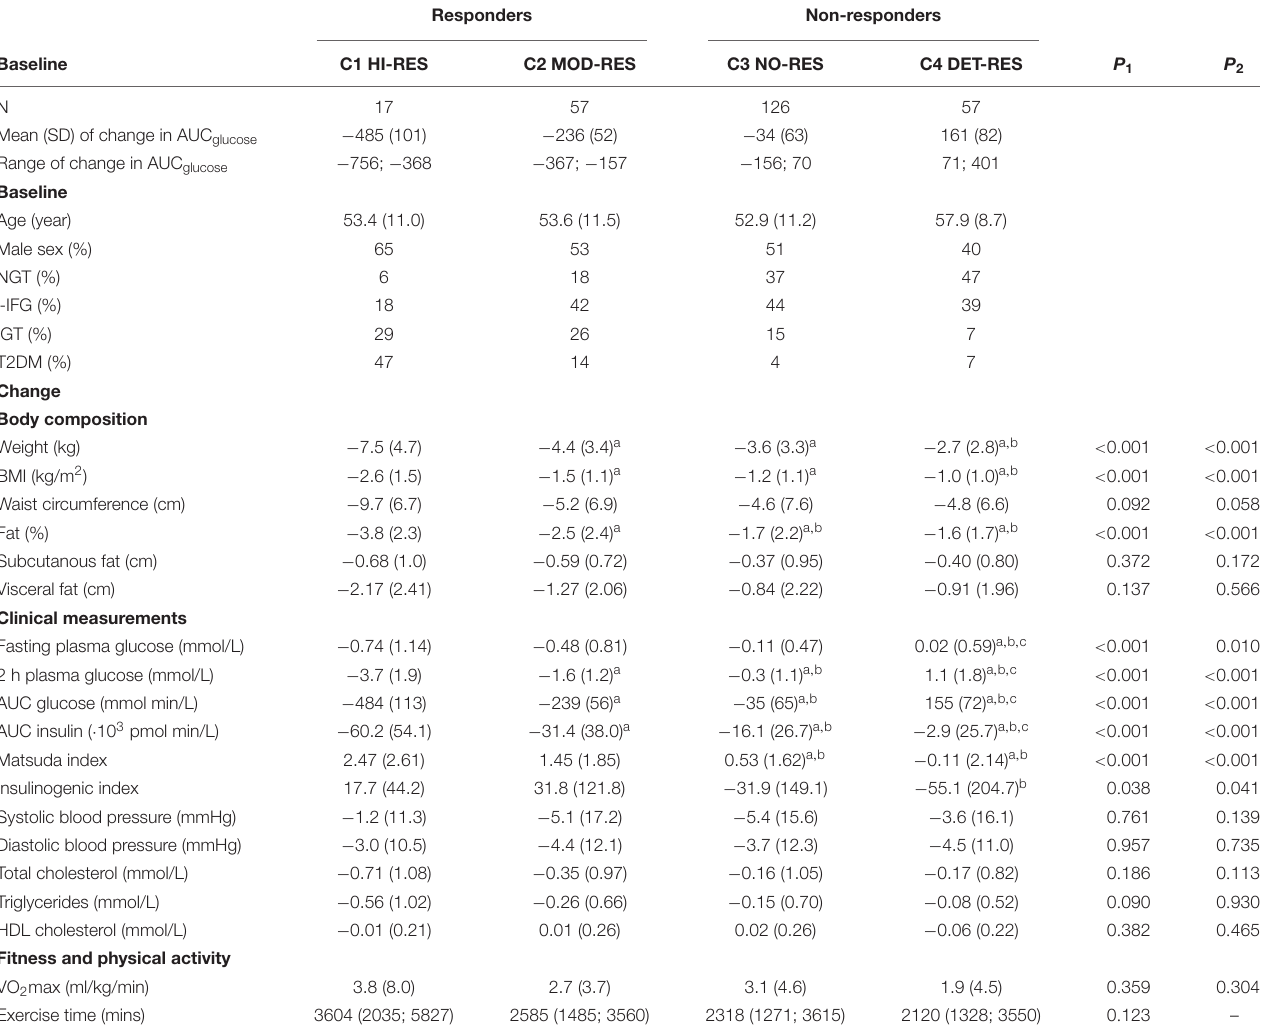
TABLE 3 | Response to the intervention based on clusters of change in AUC glucose (imputed data).